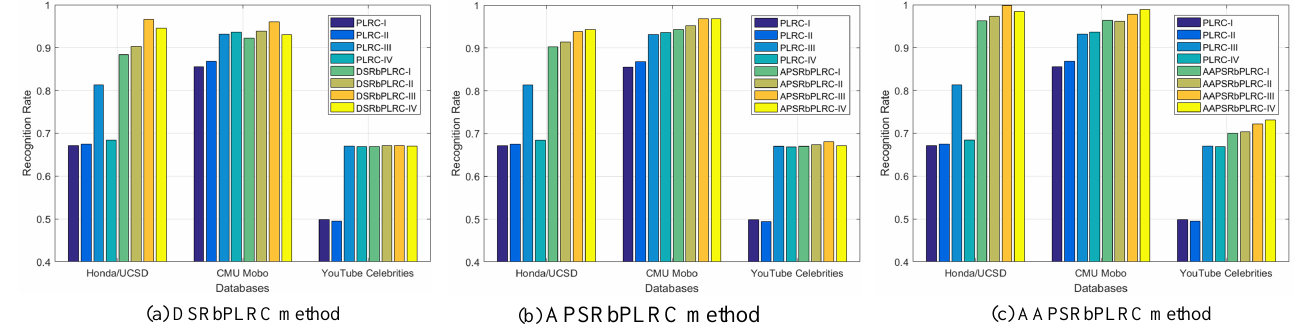
Figure 5. The average recognition rates of the DSRbPLRC, APSRbPLRC, and AAPSRbPLRC algo- rithms, in terms of large-sized videos.